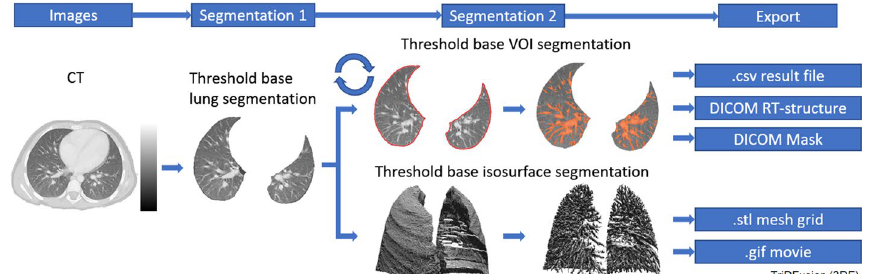
Fig. 10 Lung segmentation workflow of a computed tomography (CT) image segmented using the lung segmentation tool. The workflow illustrates how the resultant image (bronchi) is then segmented using the contour tool or the three-dimensional isosurface tool and exported. VOI, volume of